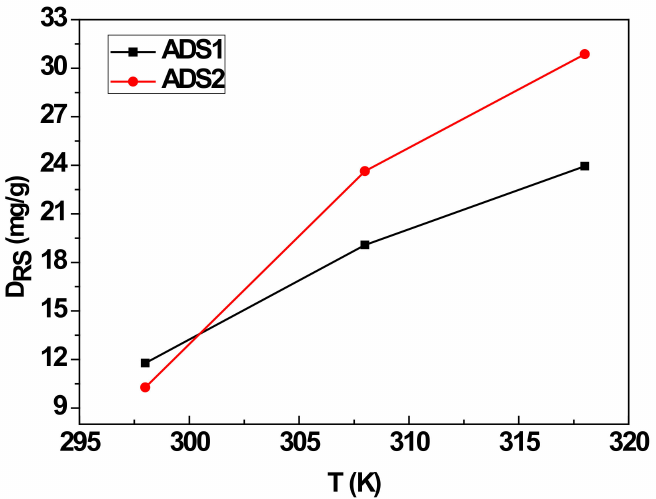
Figure 4. Impact of temperature on the parameter D RS